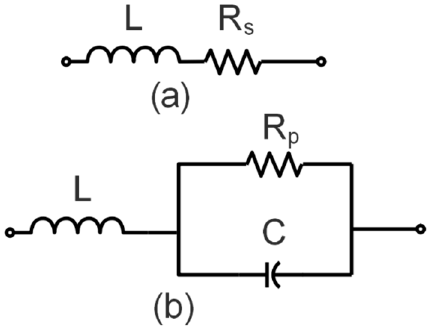
Figure 13. Models of equivalent circuits for the PIN diode in ( a ) ON state ( b ) OFF state.